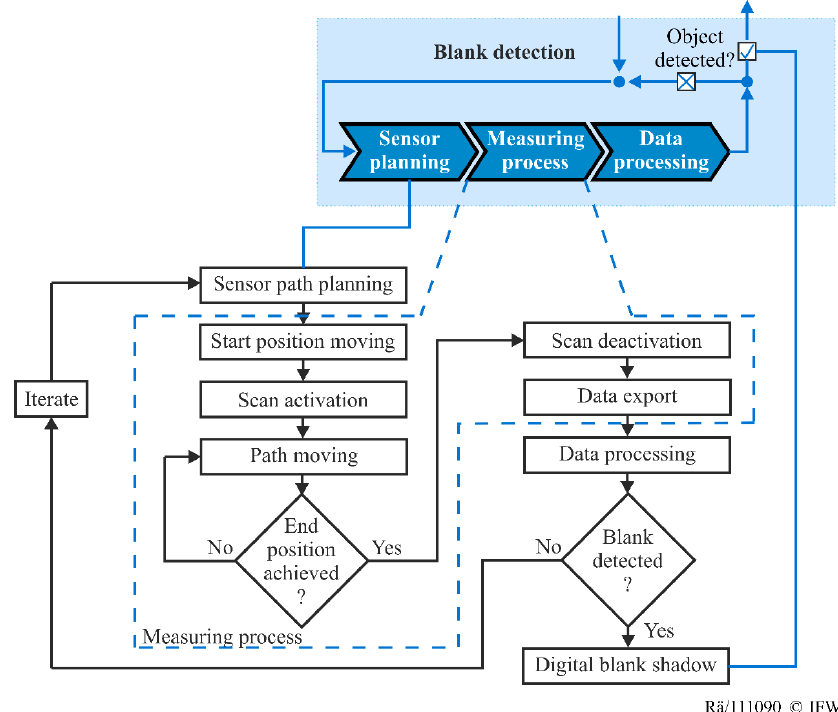
Figure 5. Flow chart of the measuring process.